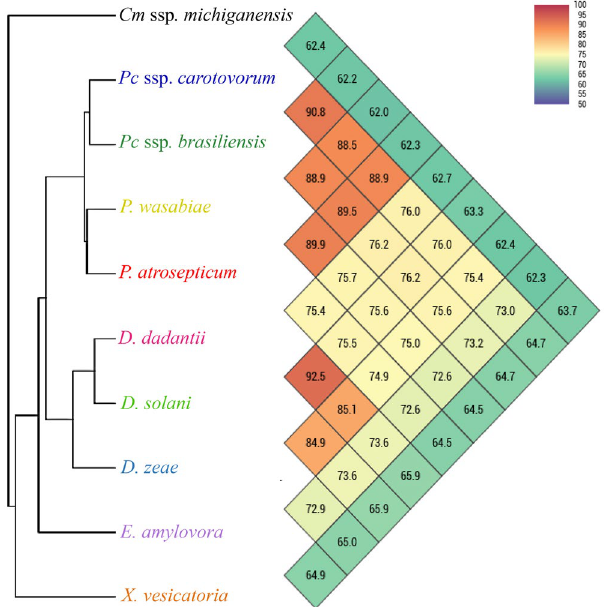
Figure 2. Overall orthologous average nucleotide identity (ANI) among bacterial genomes was calculated using Orthologous Average Nucleotide Identity Tool version 0.93 (OrthoANI). Values in color matrix boxes indicate the similarity percentage among the genomes. Clavibacter michiganensis subsp. michiganensis (NCBI accession number NC_009480), Pectobacterium carotovorum subsp. carotovorum (NCBI accession number NC_012917), P . carotovorum subsp. brasiliensis (NCBI accession number NZ_CP020350), P . wasabiae (NCBI accession number NC_013421), P . atrosepticum (NCBI accession number NZ_CP009125), Dickeya dadantii (NCBI accession number NC_014500), D . solani (NCBI accession number NZ_CP009460), D . zeae (NCBI accession number NZ_CP006929), Erwinia amylovora (NCBI accession number NC_013961) and